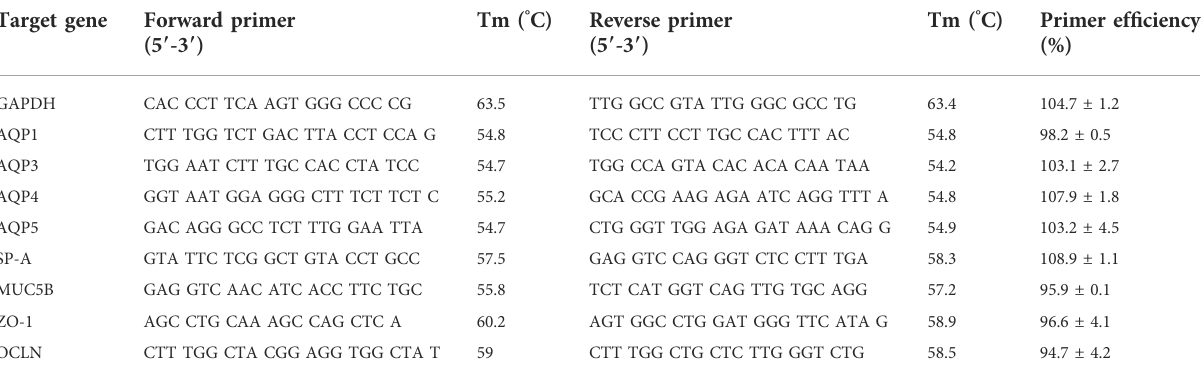
TABLE 1 Primers used in the present study. All the primers were ordered from Integrated DNA Technologies Inc., Coralville, IA, United States and tested in-house for primer ef fi ciency (represented as % Mean ± SD) which ranged between the acceptable limits (90% – 110%). Target